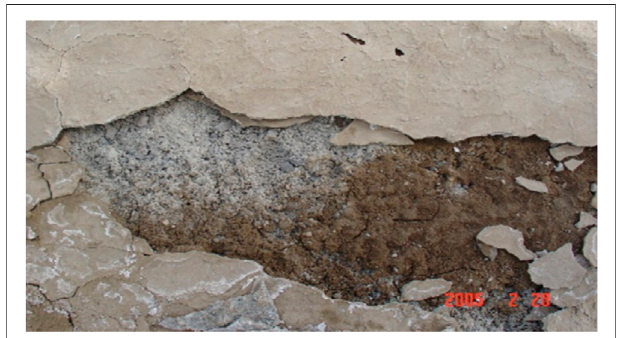
FIGURE 4 | Thaumasite formation under external sulfate attack (groundwater [SO 42 − ] = 653 mg/L) in the Yongan Dan in Keshi of China (Mingyu et al.,